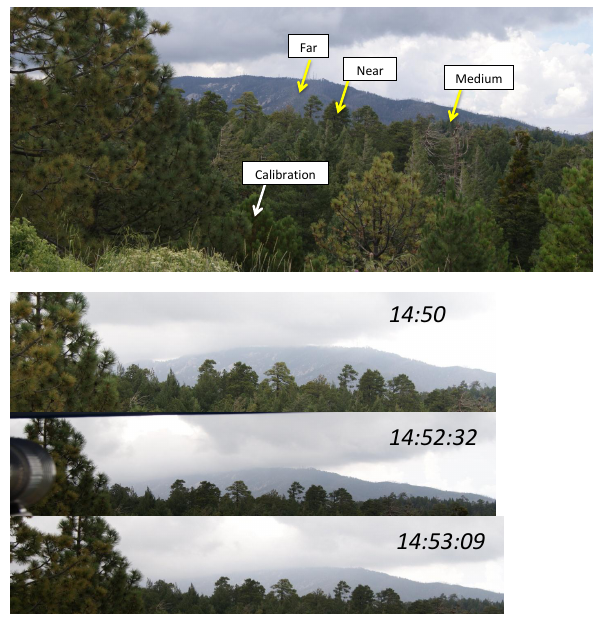
Fig. 19. View of Mt. Lemmon from Mt. Bigelow at visible wave- lengths showing the evolving opacity at the onset of the